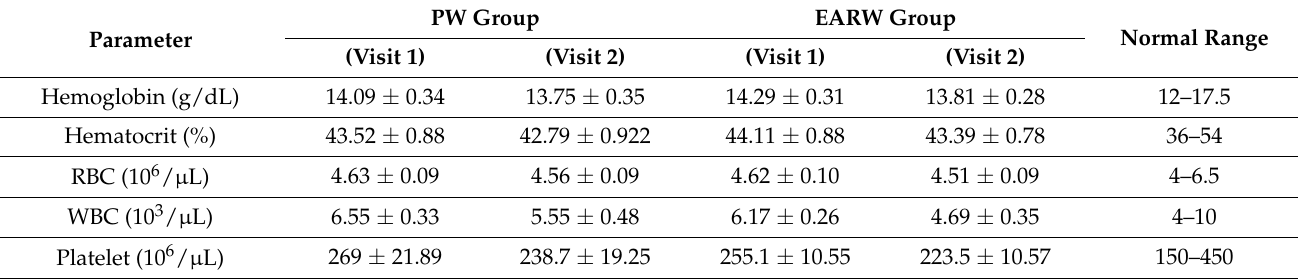
Table 4. Effect of drinking EARW on